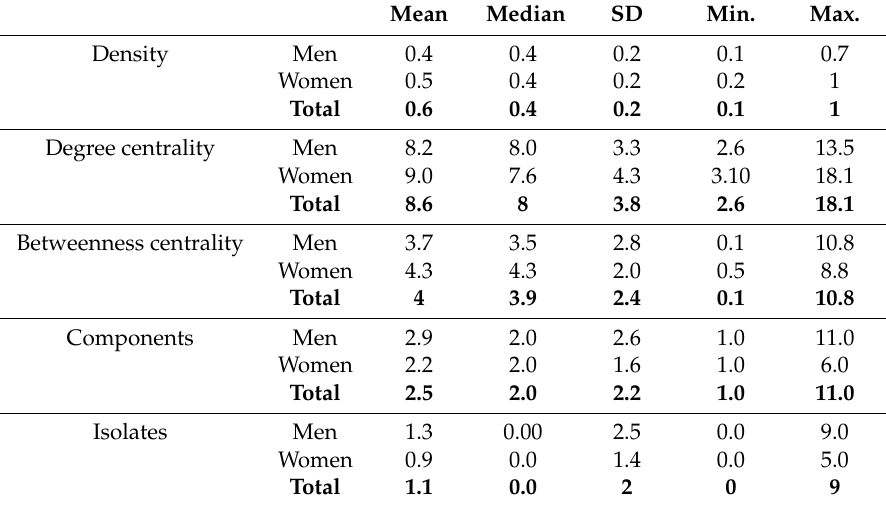
Table 1. Personal network structure